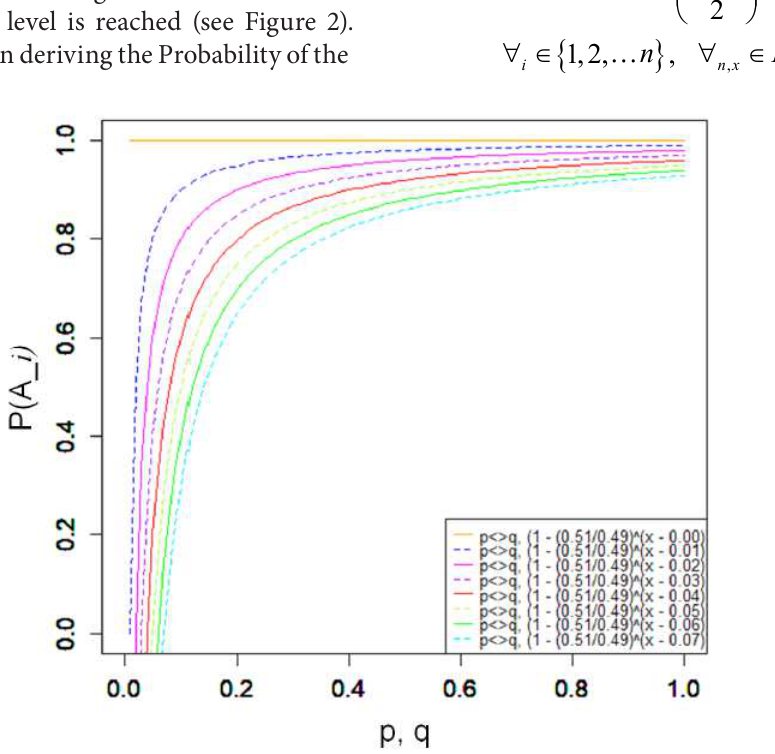
Figure 3. GRP transition probabilities of